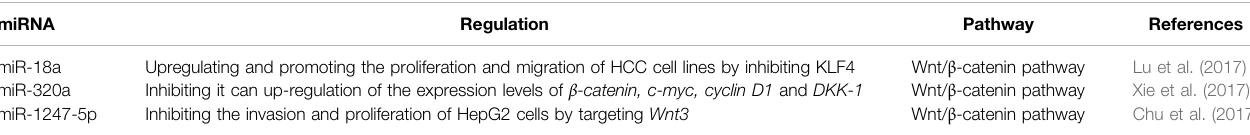
TABLE 1 | miRNAs regulate Wnt/ β -catenin pathway in liver cancer. miRNA Regulation Pathway